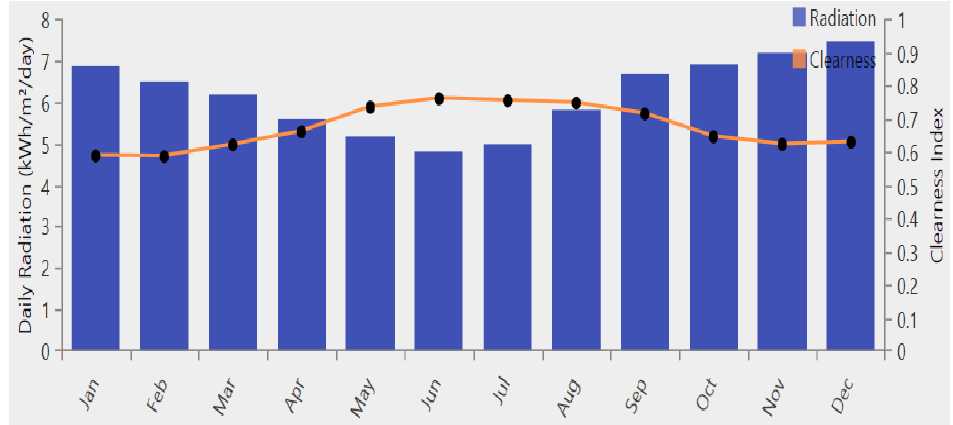
Figure 7. Annual solar radiation and clearness index profile for Windhoek. Source [60].